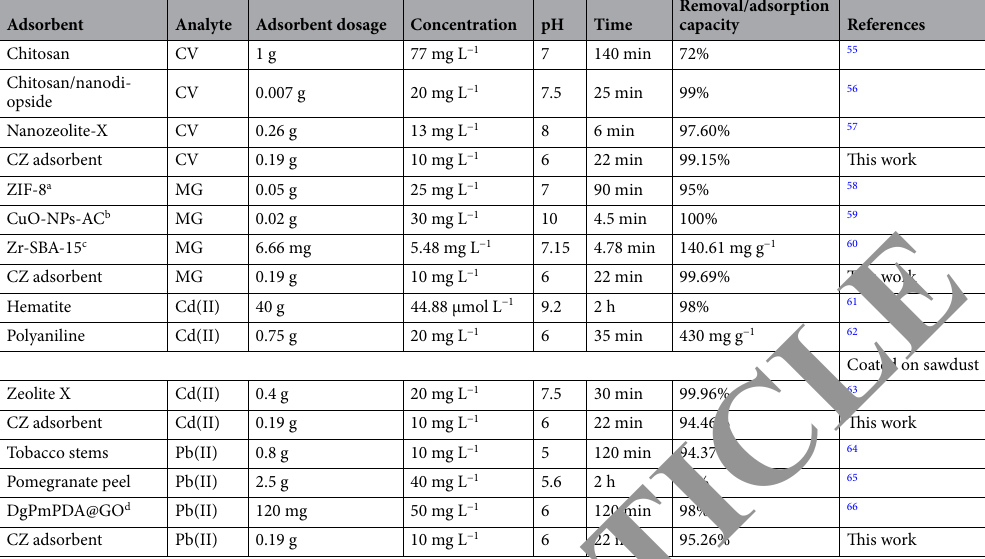
Table 5. Comparison of the CZ adsorbent with other adsorbents for removal CV, MG, Cd(II) and Pb(II). a Zeolitic imidazole framework-8, b Mn-doped CuO-Nanoparticles loaded on activated carbon, c Zirconium- containing mesostructured SBA-15 silica, d Dextrin-g-poly mphenylenediamine (DgPmPDA) and graphene oxide